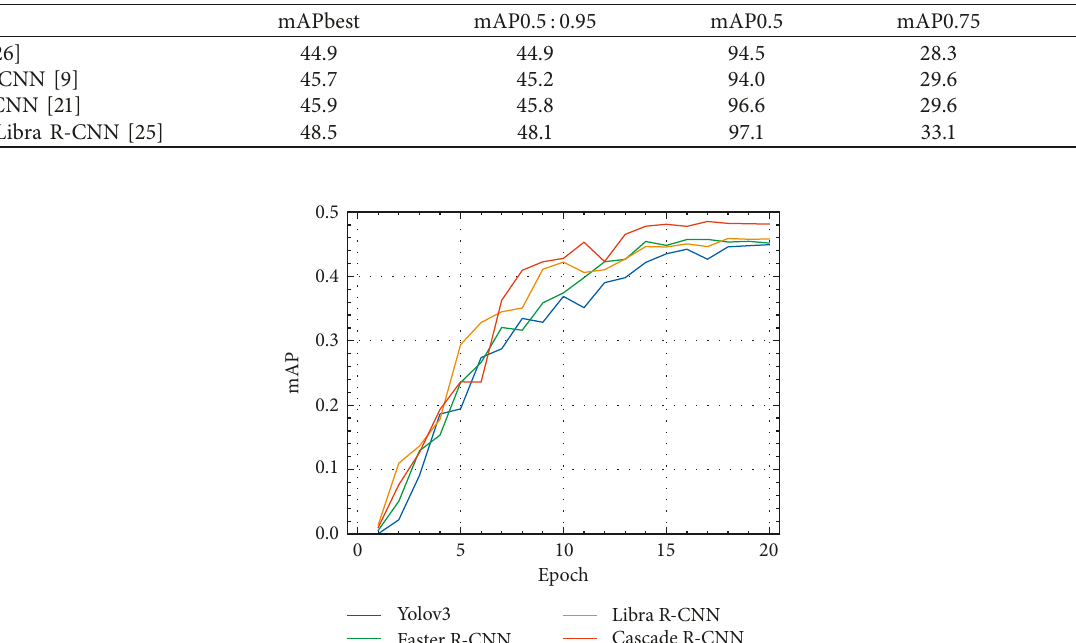
Table 1: Results of basic object detection algorithms.